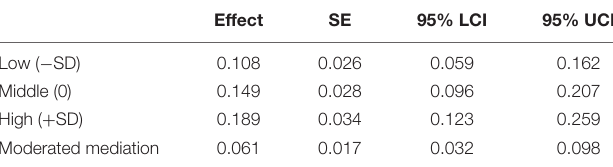
TABLE 6 | Moderated mediating